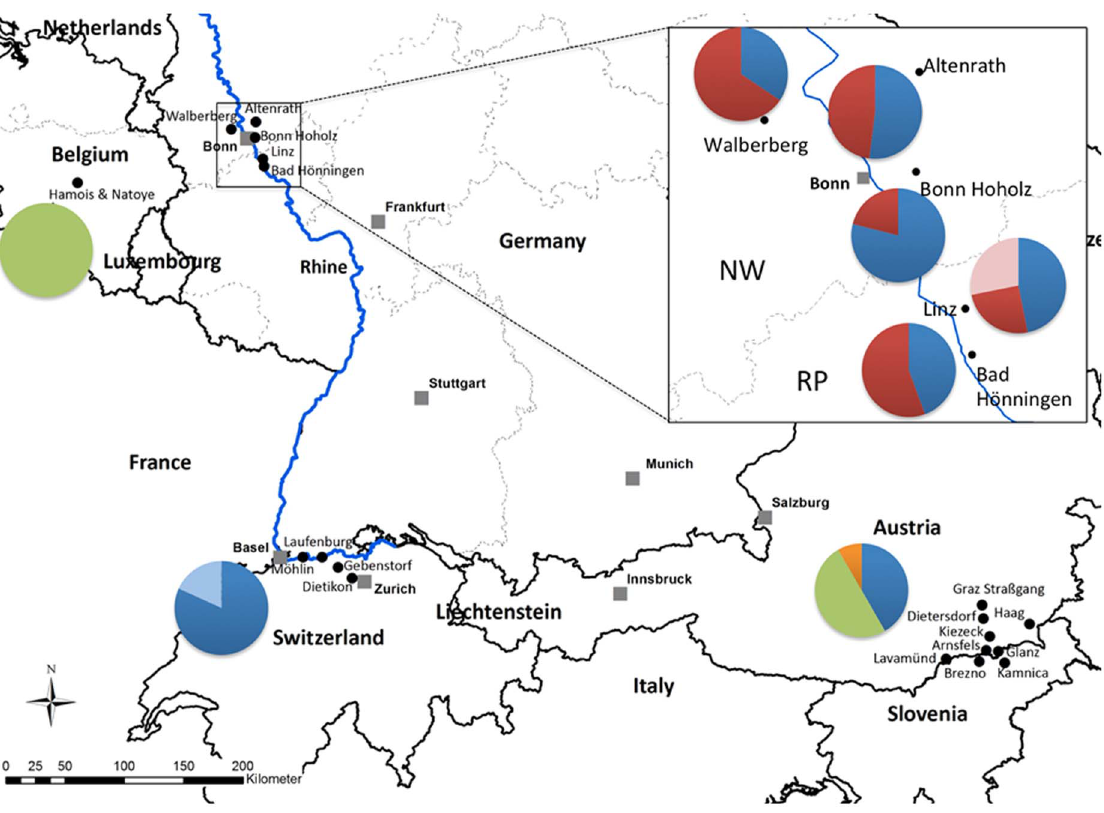
Figure 1. Sampling spots in North Rhine-Westphalia and Rhineland-Palatinate in Germany (box) as well as in Belgium, Switzerland, and Austria/Slovenia. Pie charts show the relative frequency of the six nad 4 mitochondrial DNA haplotypes. NW=North Rhine-Westphalia, RP=Rhineland-Palatinate. Haplotypes: blue=H1, red=H5, pink=H6, green=H9, orange=H10, light blue=H33. The numbers of specimens sequenced at the nad 4 locus in each population are listed in Table 1.